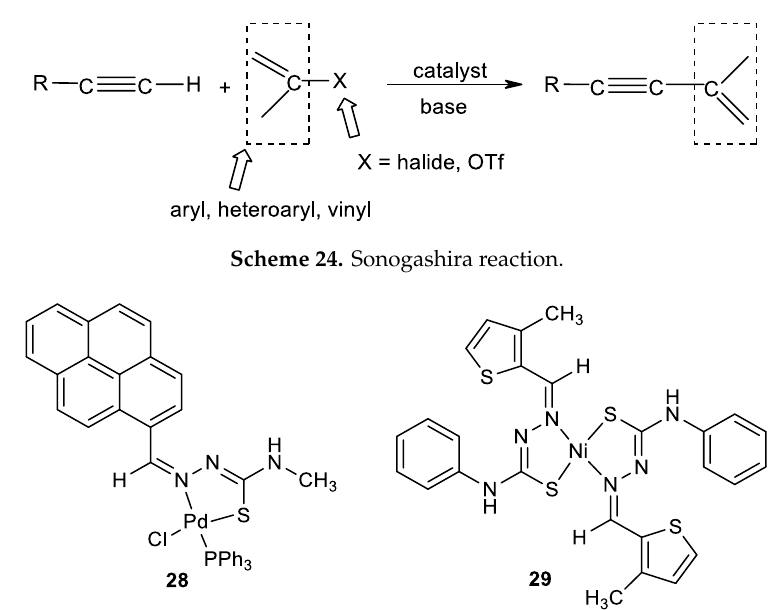
Figure 5. Representative metal complexes of thiosemicarbazones as catalysts for the Sonogashira reaction. Table 2. Suzuki – Miyaura reactions catalysed by thiosemicarbazone complexes: representative conditions and yields 1 .